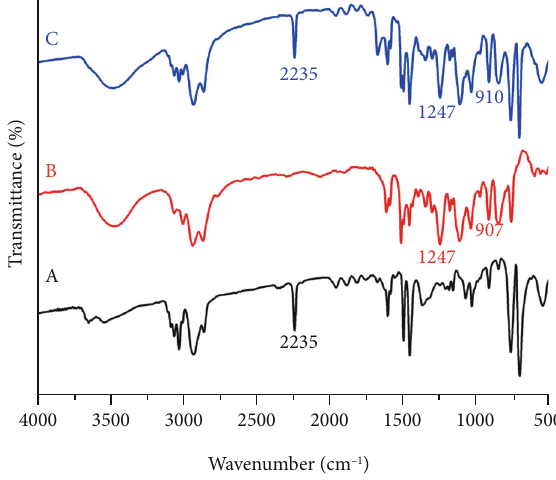
Figure 3: FT-IR spectra of (a) neat shell polymer (SAN), (b) neat epoxy resin, and (c) their corresponding core-shell capsules.